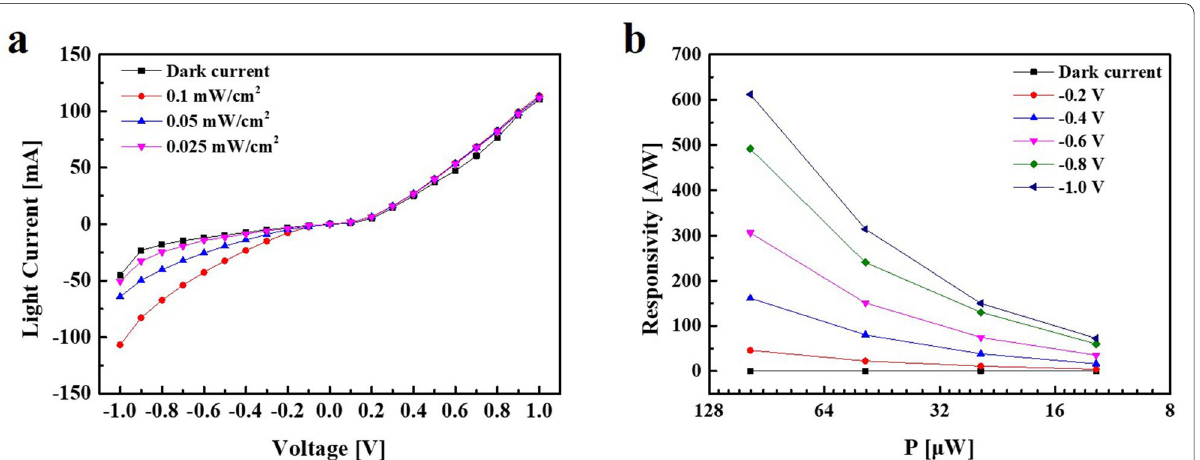
Fig. 6 Dependence of photo‑response on illumination intensity of SWIR PD3. a Current–voltage (I–V) characteristics at different illumination intensities using light (1400 nm wavelength), b the responsivities of the device as a function of incident powers at different bias